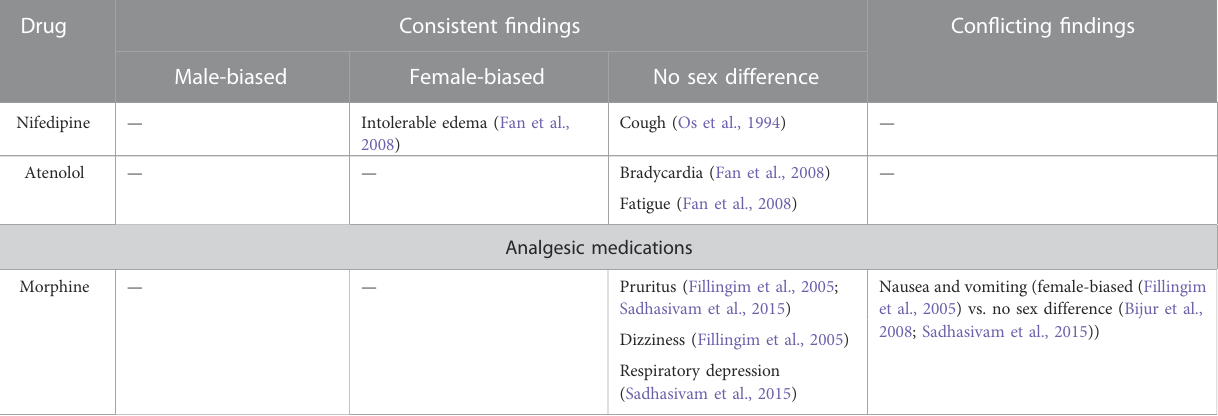
TABLE 2 ( Continued ) Summary of fi ndings of sex difference